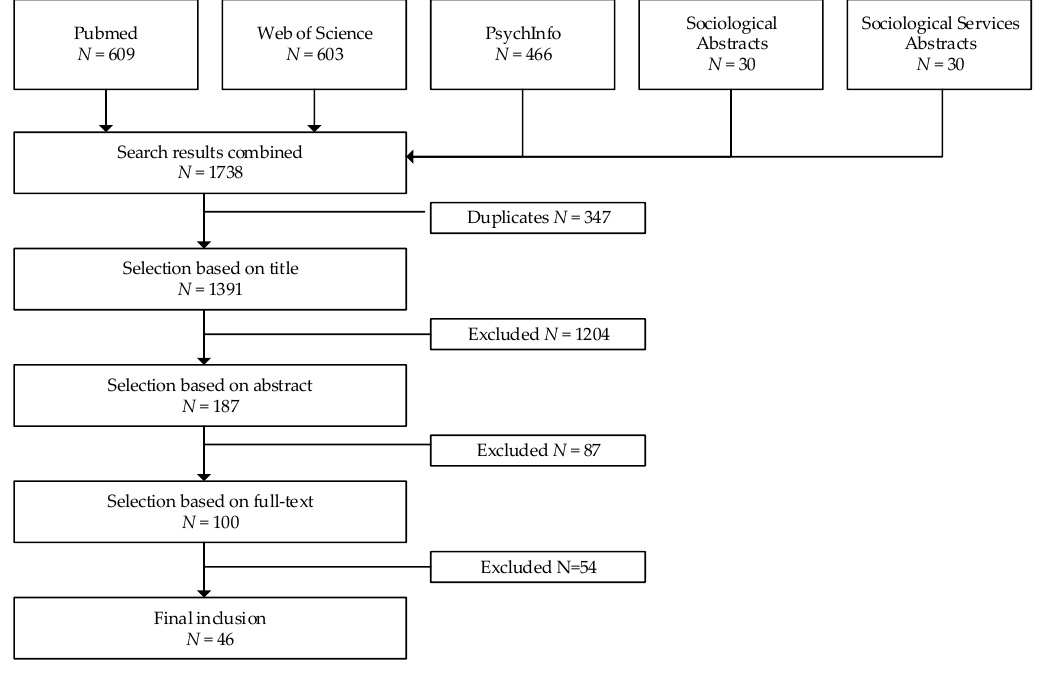
Figure 1. Flowchart of the selection process. Table 2. Inclusion and exclusion criteria.